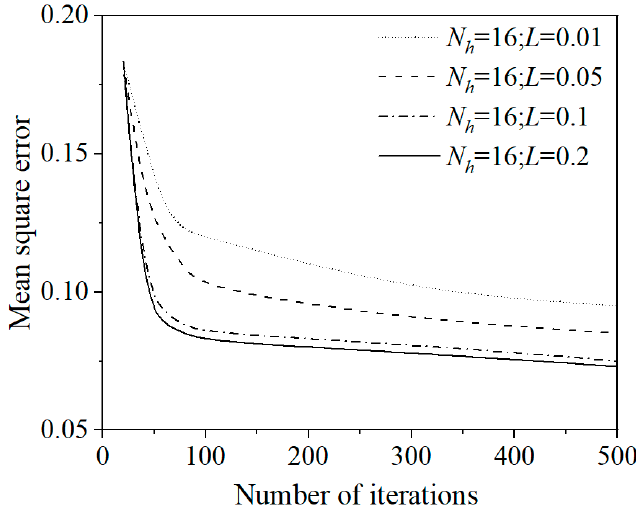
Figure 17. Mse of the training set in the training phase.